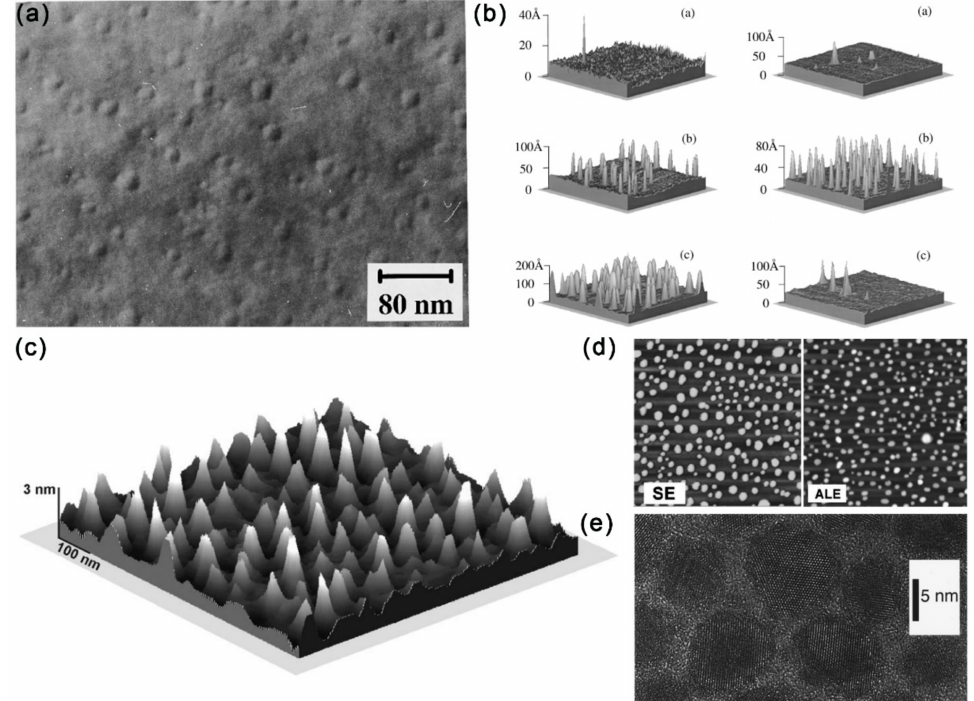
Figure 4. ( a ) TEM image of GaSb/GaAs quantum dots formed with GaSb deposition. Reproduced with permission [49]. Copyright 1995, American Institute of Physics. ( b ) AFM images of InSb grown on GaAs at 400 ◦ C: ~1.5 ML InSb, ~ 2.0 ML InSb and ~ 3.5 ML InSb (left), and AFM images of 2.0 ML InSb grown on GaAs: ~350 ◦ C, ~430 ◦ C and ~460 ◦ C (right). Reproduced with permission [50]. Copyright 1996, American Institute of Physics. ( c ) AFM image of a 0.8 × 0.8 µ m 2 surface area showing the formation of GaAs dots [51]. Copyright 1998, American Institute of Physics. ( d ) AFM images of two samples with nominally 2.5 ML of InSb on InAs. Left: sample grown using SE; Right: sample grown using atomic-layer epitaxy. Reproduced with permission [52]. Copyright 2006, American Institute of Physics. ( e ) Higher resolution TEM image of InAs nanocrystals Reproduced with permission [42]. Copyright 1996, American Institute of